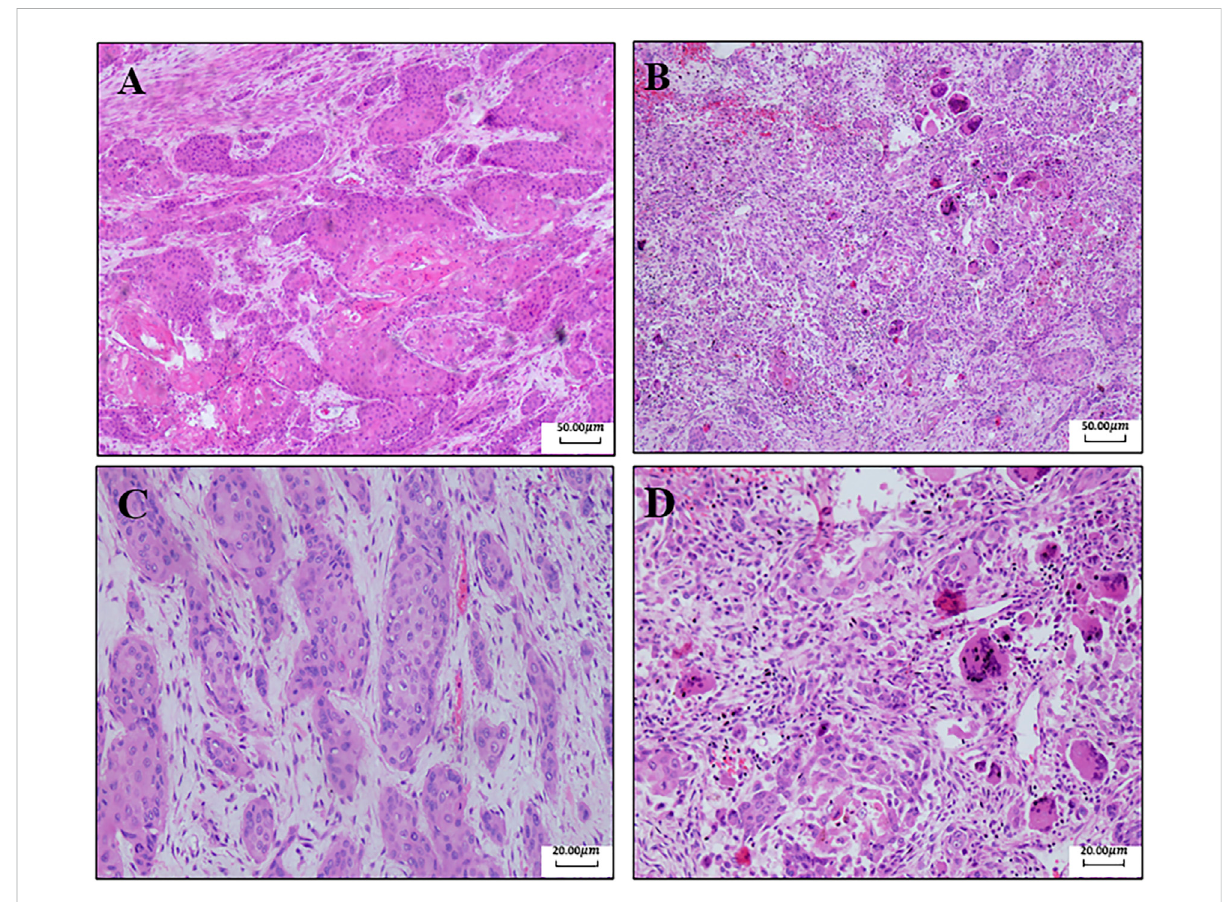
FIGURE 1 Pathological results of the right palm and right forearm. (A) Pathology of the right palm (40x): there are a lot of multinucleated giant cells and in fl ammatorycellsinthetissue.Fibrosisoccurs,andcellsareswellinganddeformed.Thesearethechangesafterchemotherapy. (B) Pathologyofthe right forearm (40x). (C) Pathology of the right palm (100x). (D) Pathology of the right forearm (100x).